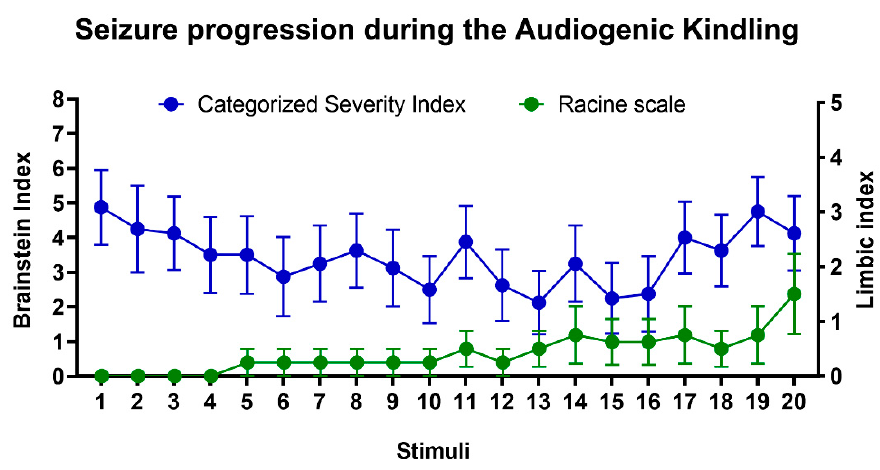
Figure 2. Evolution of audiogenic kindling (AK) in WARs. Mean of brainstem (blue circles) and limbic (green circles) seizure severity during AK. Only brainstem generalized tonic-clonic seizures were detected at the beginning of the protocol; however, during the AK, limbic seizures coexist with those that originated from the brainstem. Data are represented by mean ± standard error mean ( n = 8/group).